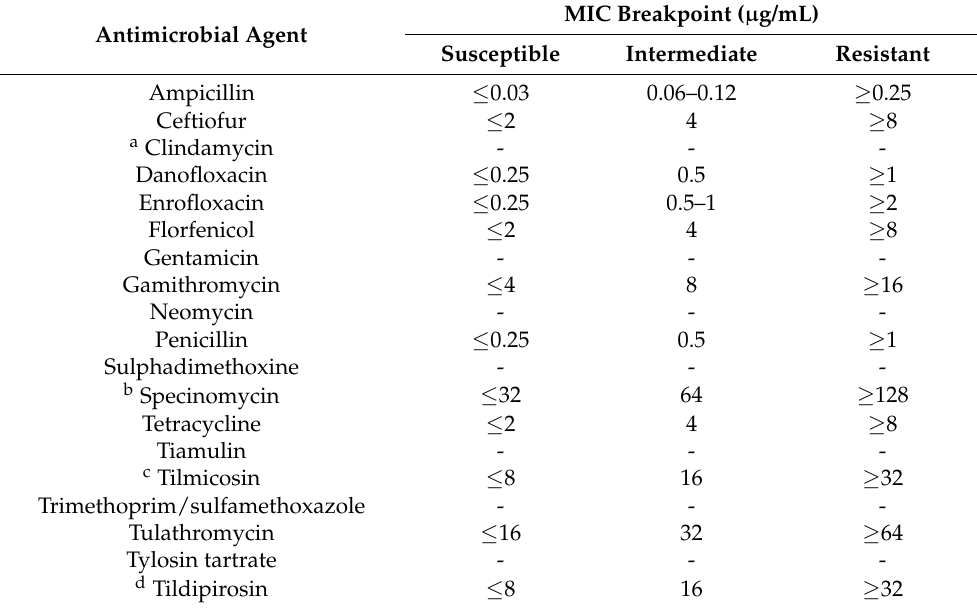
Table 2. Summary table of CLSI veterinary clinical MIC breakpoints used for BRD isolates. MIC Breakpoint ( µ g/mL) Antimicrobial Agent Susceptible Intermediate Resistant Ampicillin